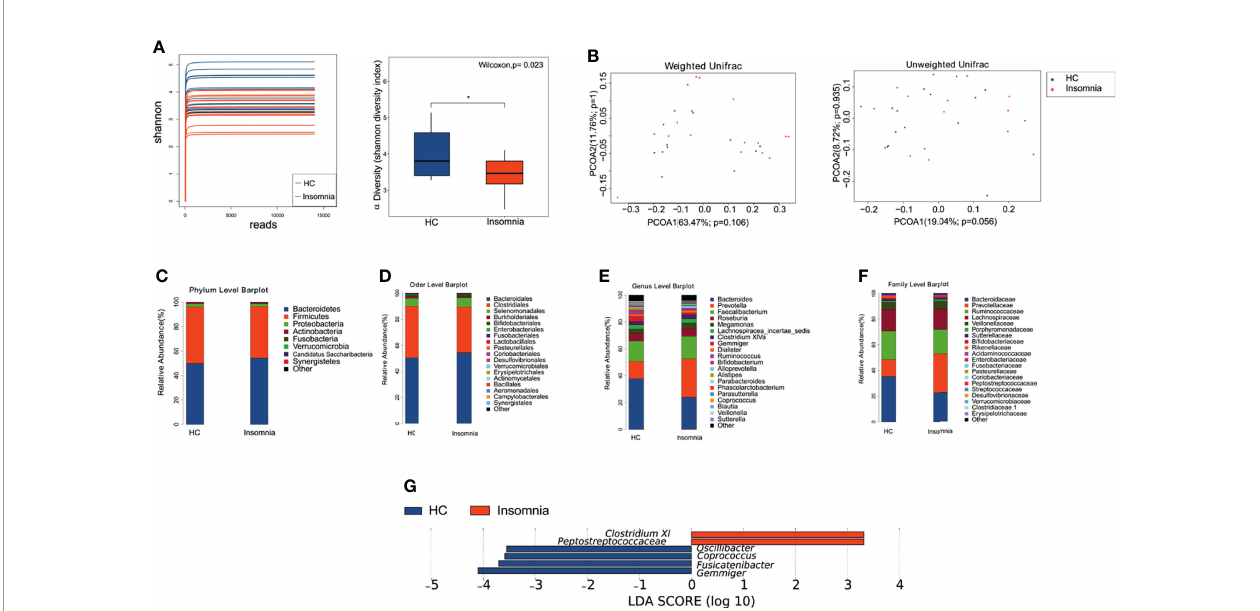
FIGURE 1 | Patients with insomnia showed differential gut microbial pro fi les compared with healthy controls. (A) a -diversity of Shannon index between insomnia and healthy control groups. *p < 0.05. (B) Plots of weighted and unweighted UniFrac PCoA of all samples. Orange dots: healthy controls; blue dots: insomnia patients. (C – F) Bar graphs of relative abundance of gut bacteria in healthy controls (A) and insomnia patients (B) at the levels of phylum, order, family, and genus. (G) Bar graphs of LEfSe analysis. Orange and blue bars represent the impact degree of enrichment of certain taxa in the healthy controls and insomnia patients, respectively. The LEfSe score threshold was 3 or -3. PCoA, principal coordinates analysis; LEfSe, linear-discriminant-analysis-effect-size; LDA, linear discriminant analysis; HC, Healthy